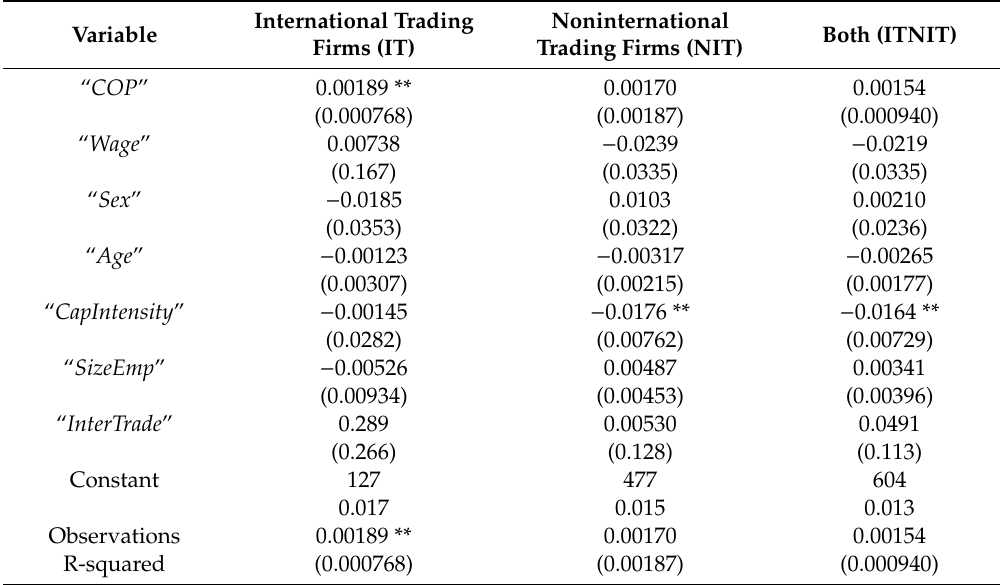
Table A3. Correlates of ROE for international trading firms and non-international-trading firms.